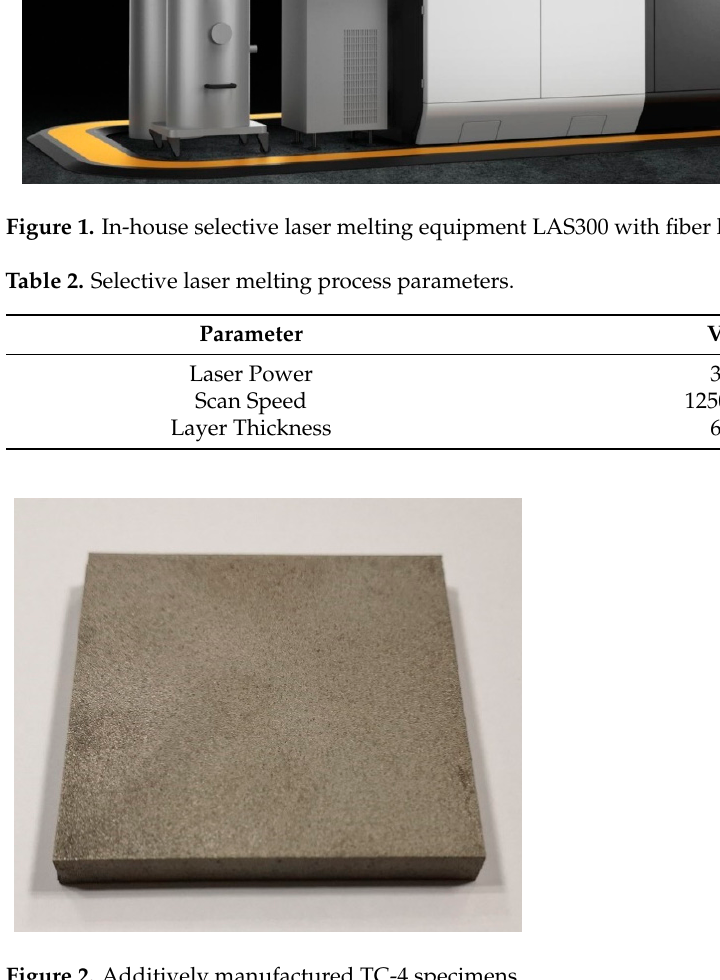
Figure 2. Additively manufactured TC-4 specimens.